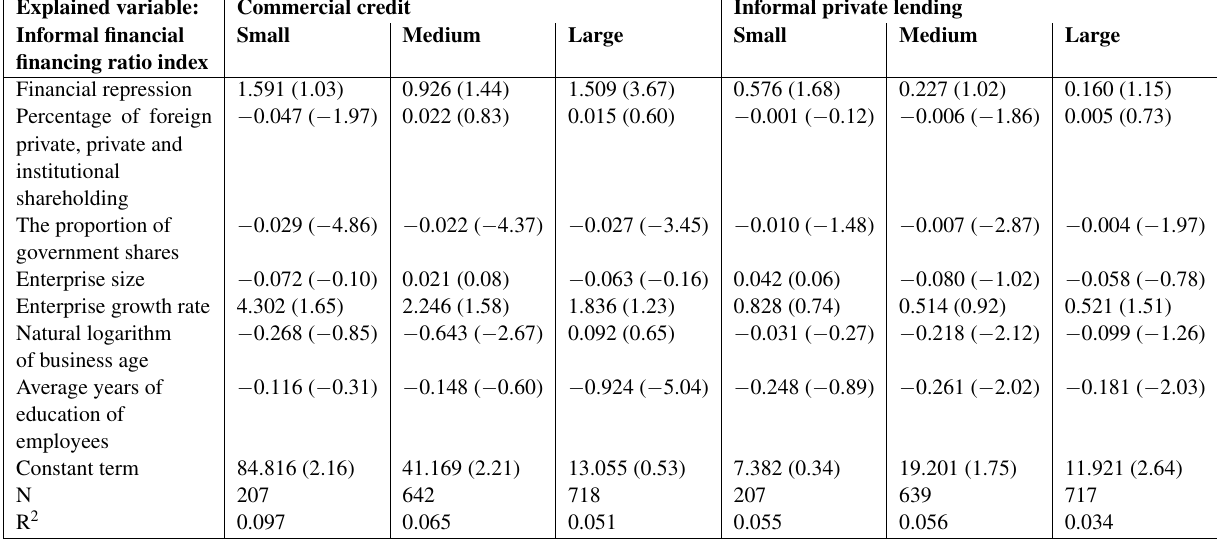
Table 2 Regression results of samples divided by